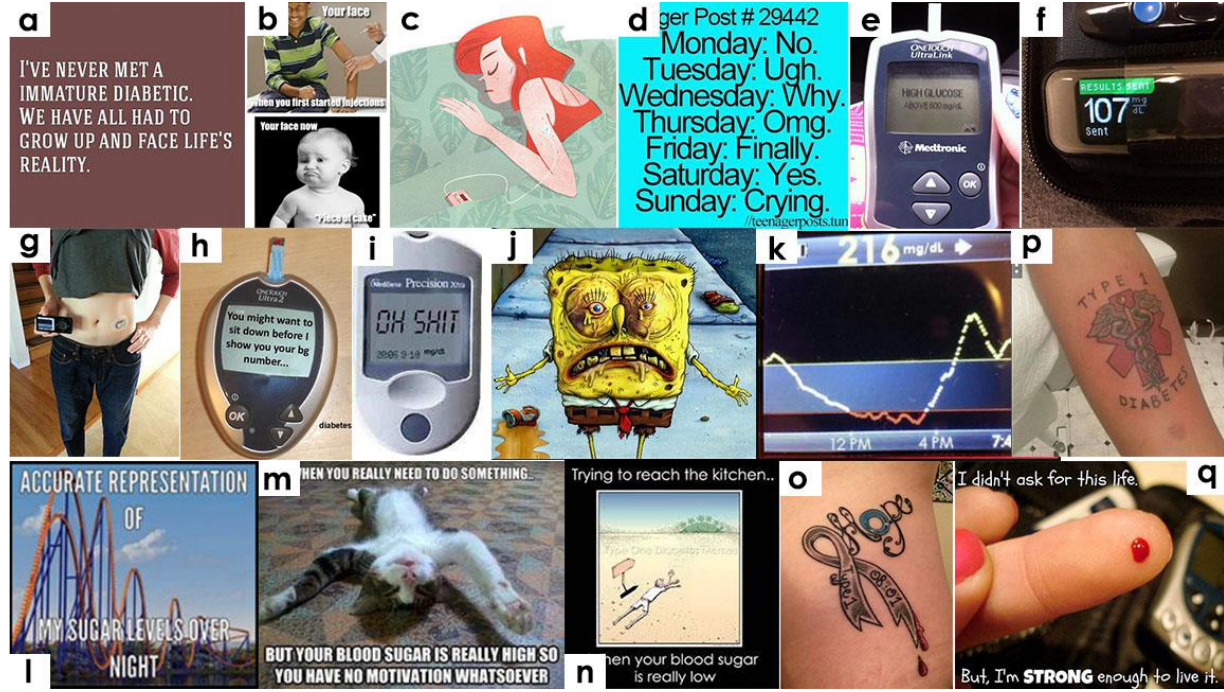
Figure 2. Images related to the beginning of diabetes and related illness narratives on Tumblr.